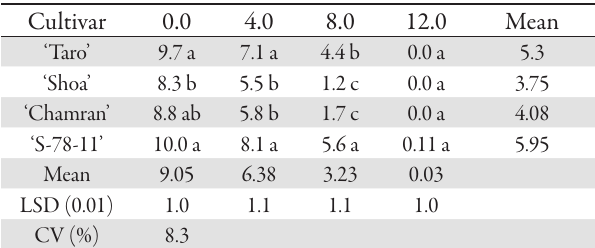
Tab. 2. Effect of salinity (ds m -2 ) on germination speed